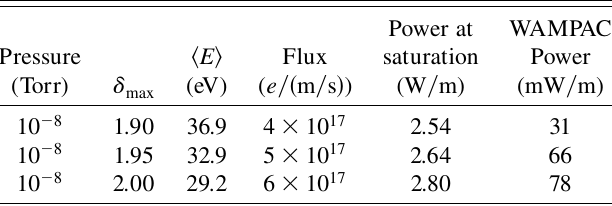
TABLE III. Simulated power in WAMPAC as a function of the maximum of the